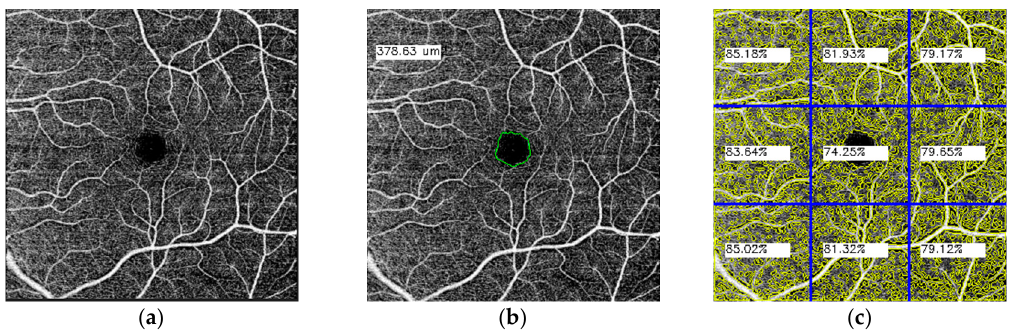
Figure 1. Example of the input ( a ) of the system and the outputs: avascular zone ( b ) and vascular zone ( c